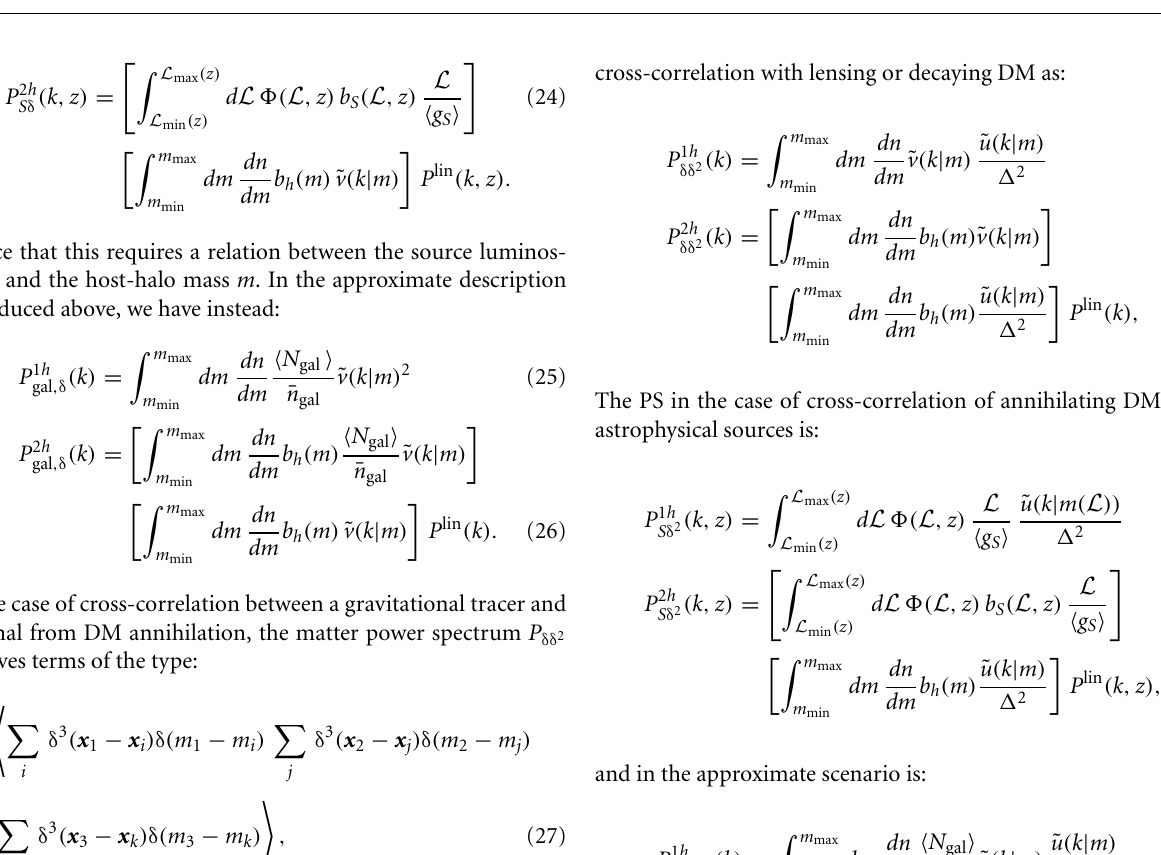
FIGURE 2 | 3D power spectra. 3D power spectra. Left: Auto-correlation 3D PS of annihilating DM in the three scenarios described in the text, at z = 0. Right: Cross-correlation 3D PS of annihilating/decaying DM with lensing and galaxy tracers; the total, 1-halo and 2-halo terms are explicitly